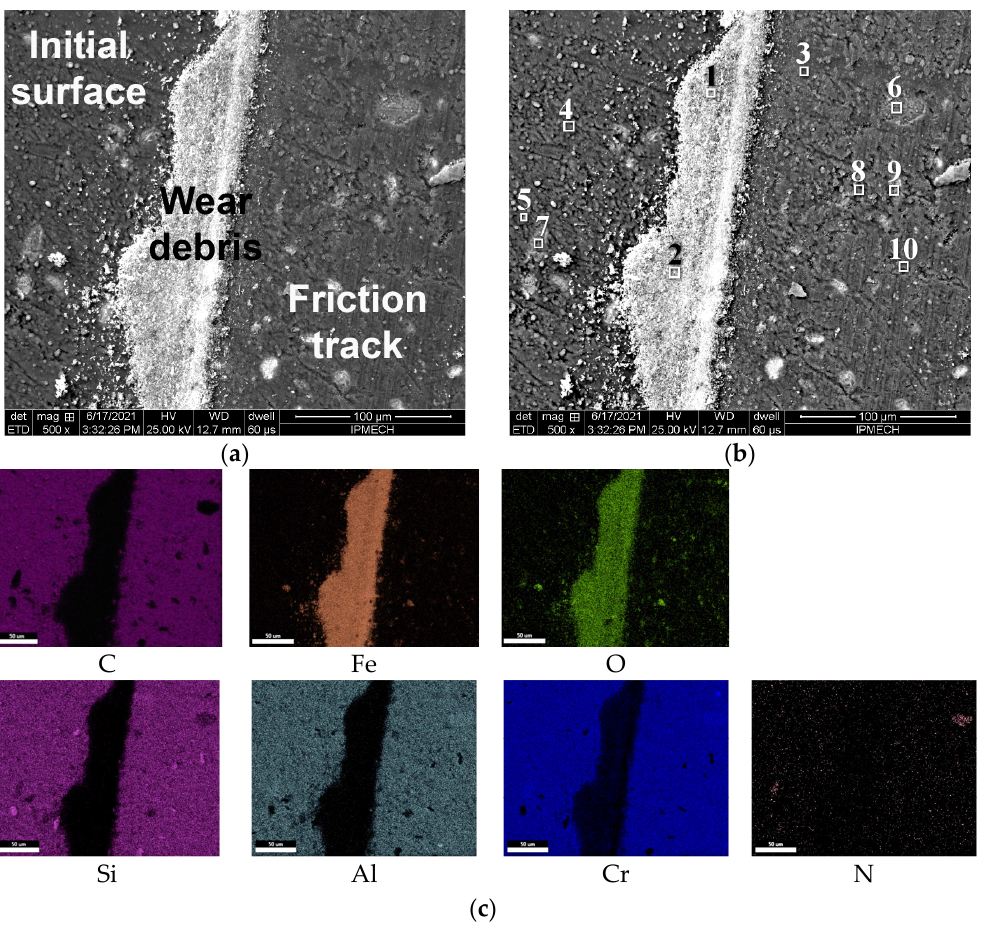
Figure 2. Photo ( a ) and profile ( b ) of the sample surface after the test. The image of the sample surface at the boundary of the upper edge of the friction track (area 1) and element distribution maps is shown in Figure 3, and the elemental composition of the characteristic zones is in Table 2. A graphical representation of the for example, in [33], is inappropriate since it is impossible to predict the compositions of results, as done, for example, in [33], is inappropriate since it is impossible to predict the secondary structures. compositions of secondary structures.